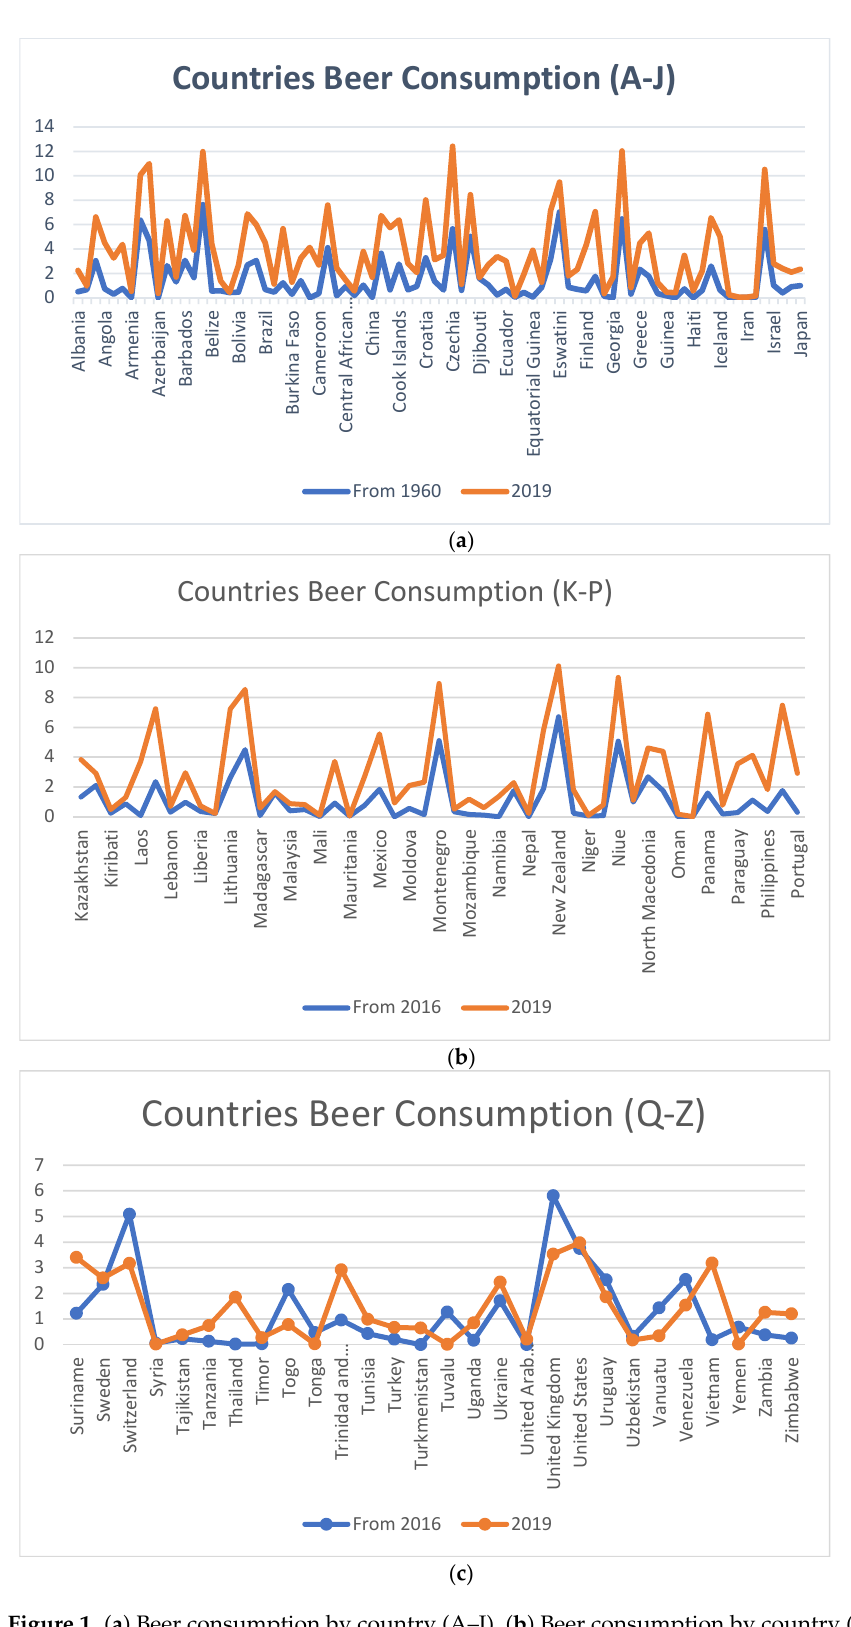
Figure 1. ( a ) Beer consumption by country (A–J). ( b ) Beer consumption by country (K–P). ( c ) Beer consumption by country